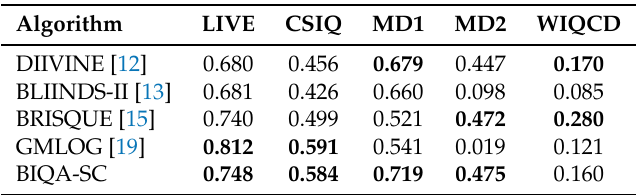
Table 8. The SROCC of the competing algorithms when trained on TID2013 database [39]. The best two algorithms are highlighted in